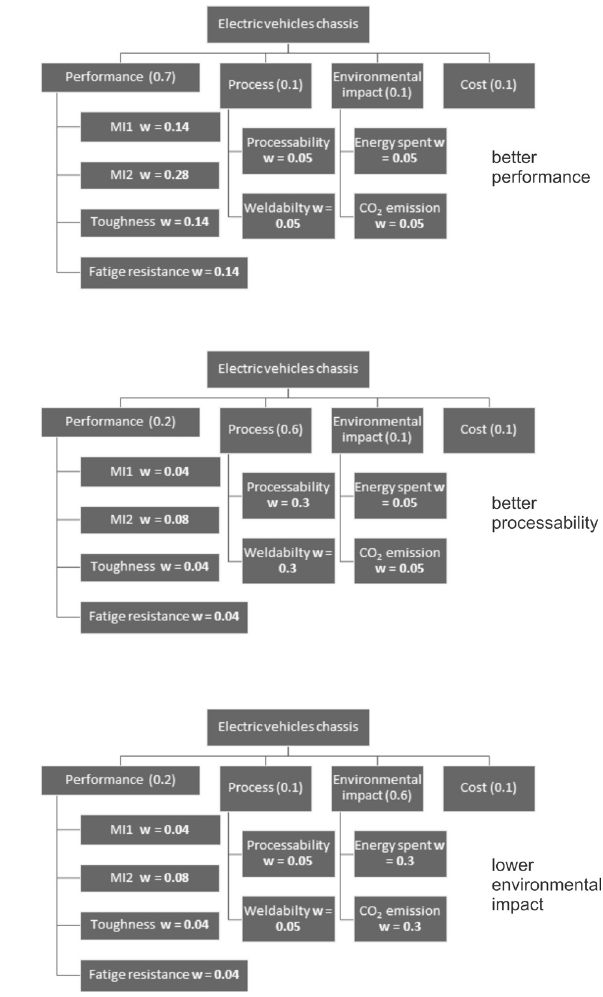
Figure 9. Criteria weights (w) employed for examining the candidate Al alloys for chassis.